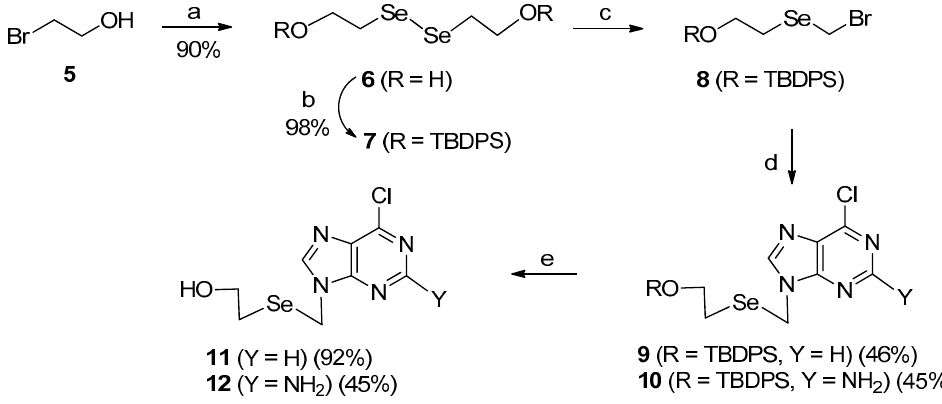
Scheme 1. Synthesis of 6-chloro- and 2-amino-6-chloropurine derivatives 11 and 12